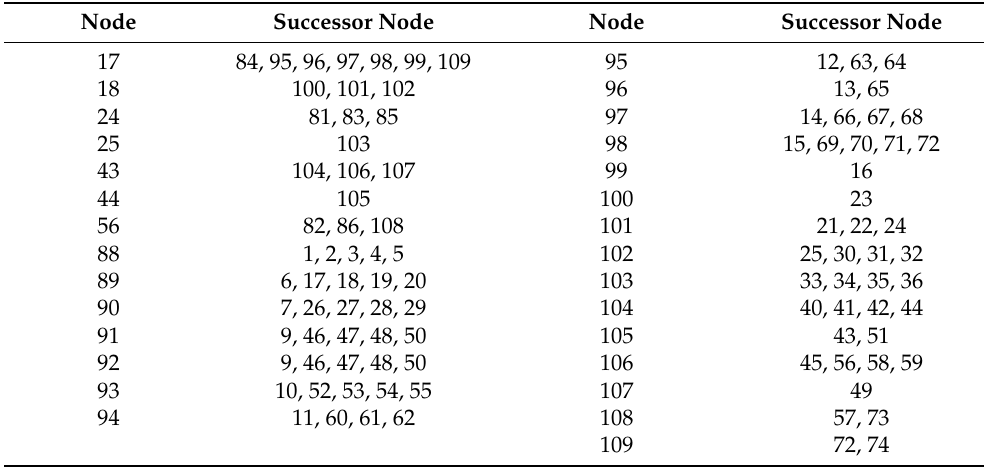
Table 1. The directed independence edges between the power network (PN) and communication network (CN) in the China Electric Power Research-Cyber-Physical System (CEPR-CPS).